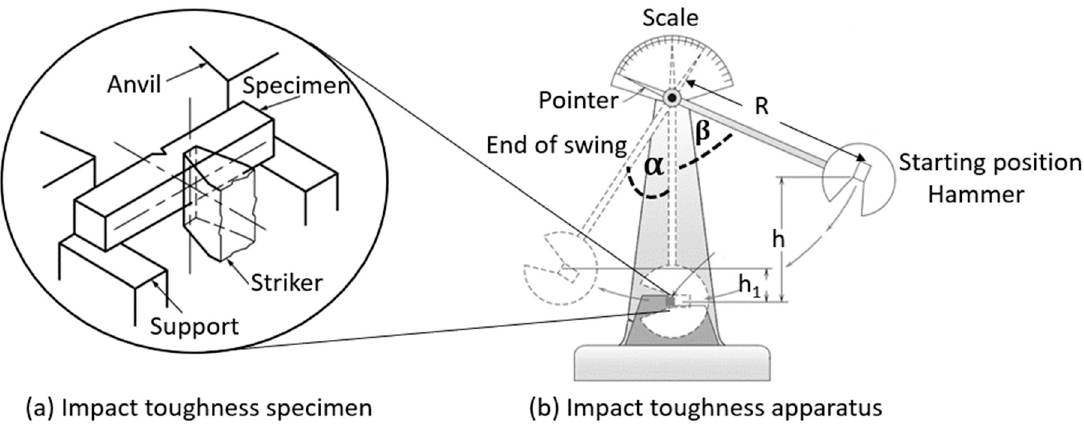
Figure 2. ( a ) Schematic description of Charpy impact toughness test specimen positioning; ( b ) drawing of impact testing apparatus.